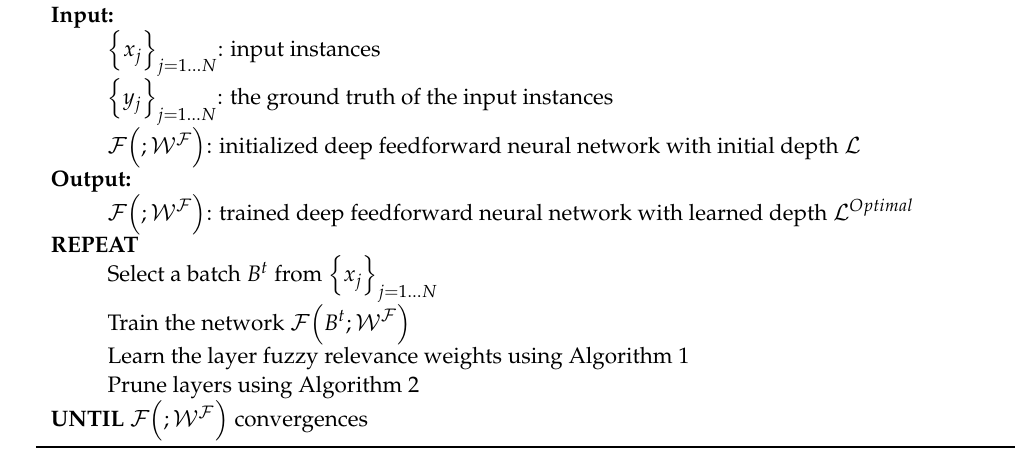
Learn the layer fuzzy relevance weights using Algorithm 1 Prune layers using Algorithm